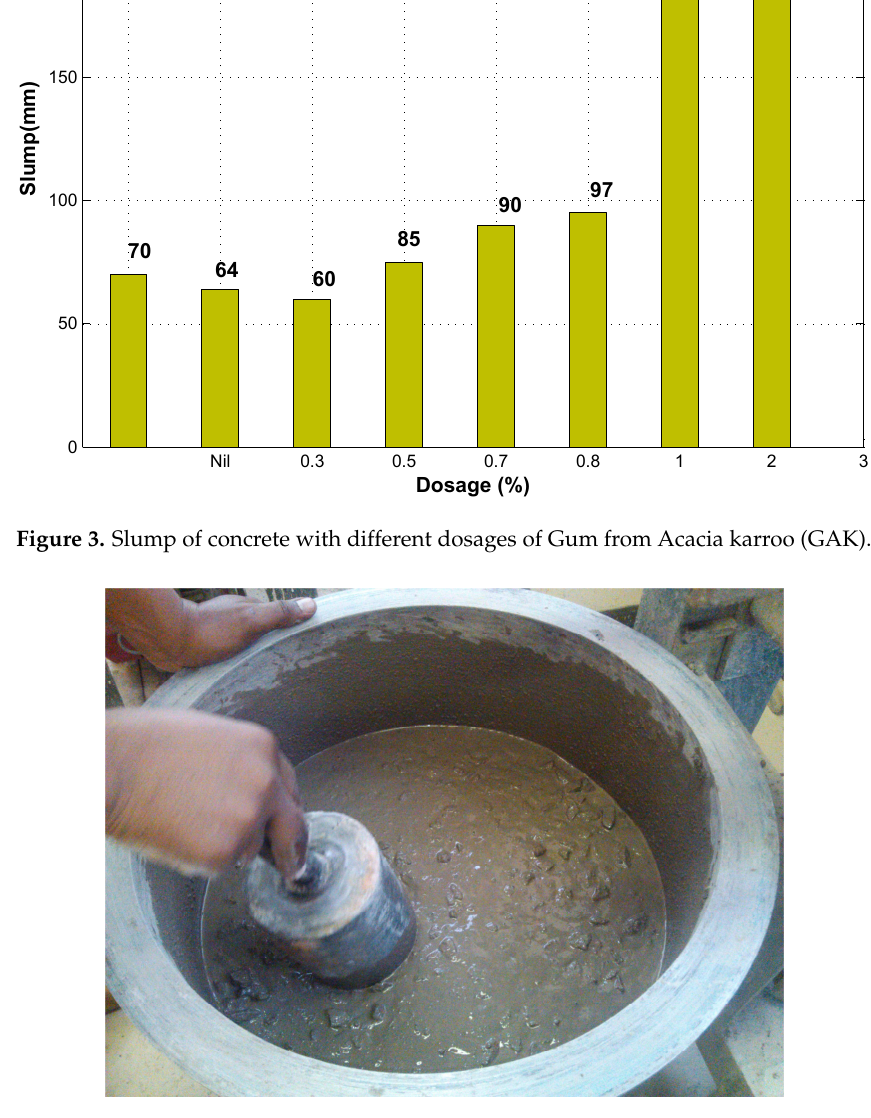
Figure 4. Concrete after the addition of a 2% GAK